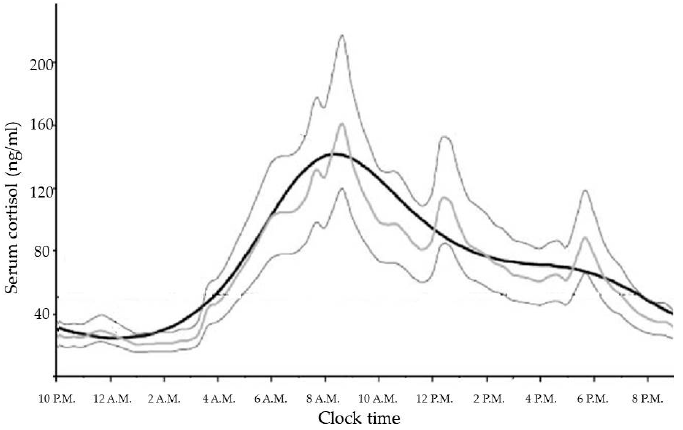
Figure 1. Daily cortisol rhythm in healthy volunteers [23].